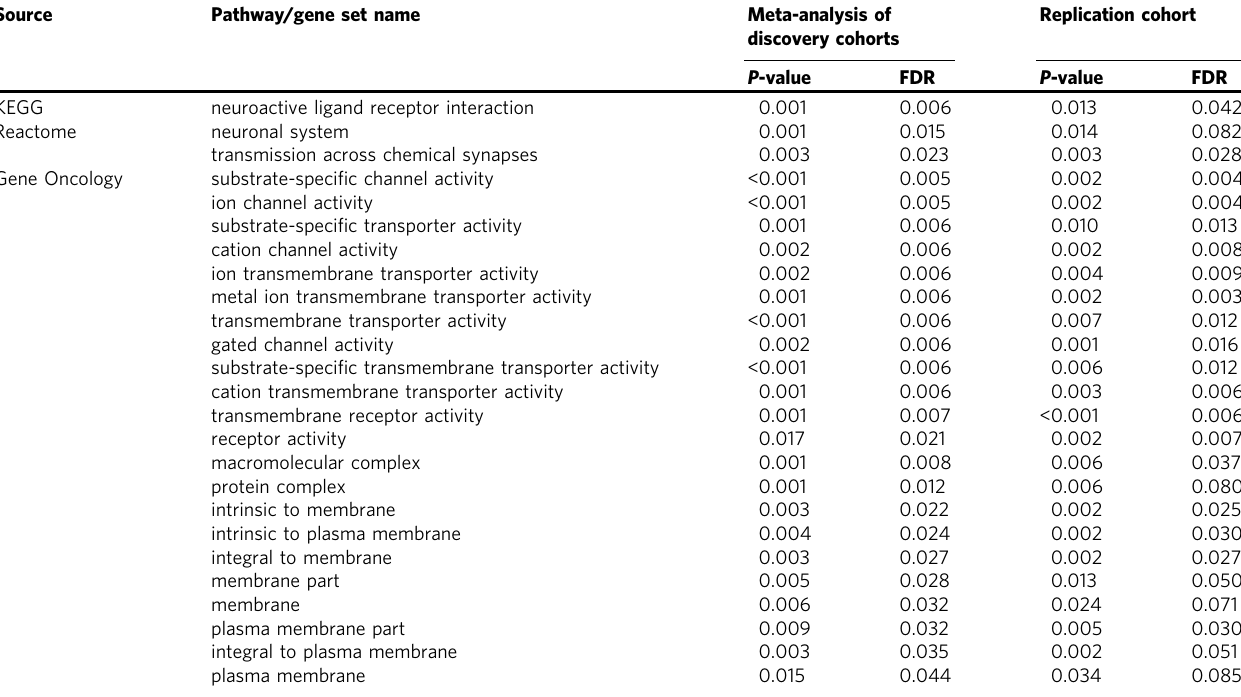
Table 3 Pathways and GO terms in discovery and replication with a threshold of FDR < 0.25 in both phase Source